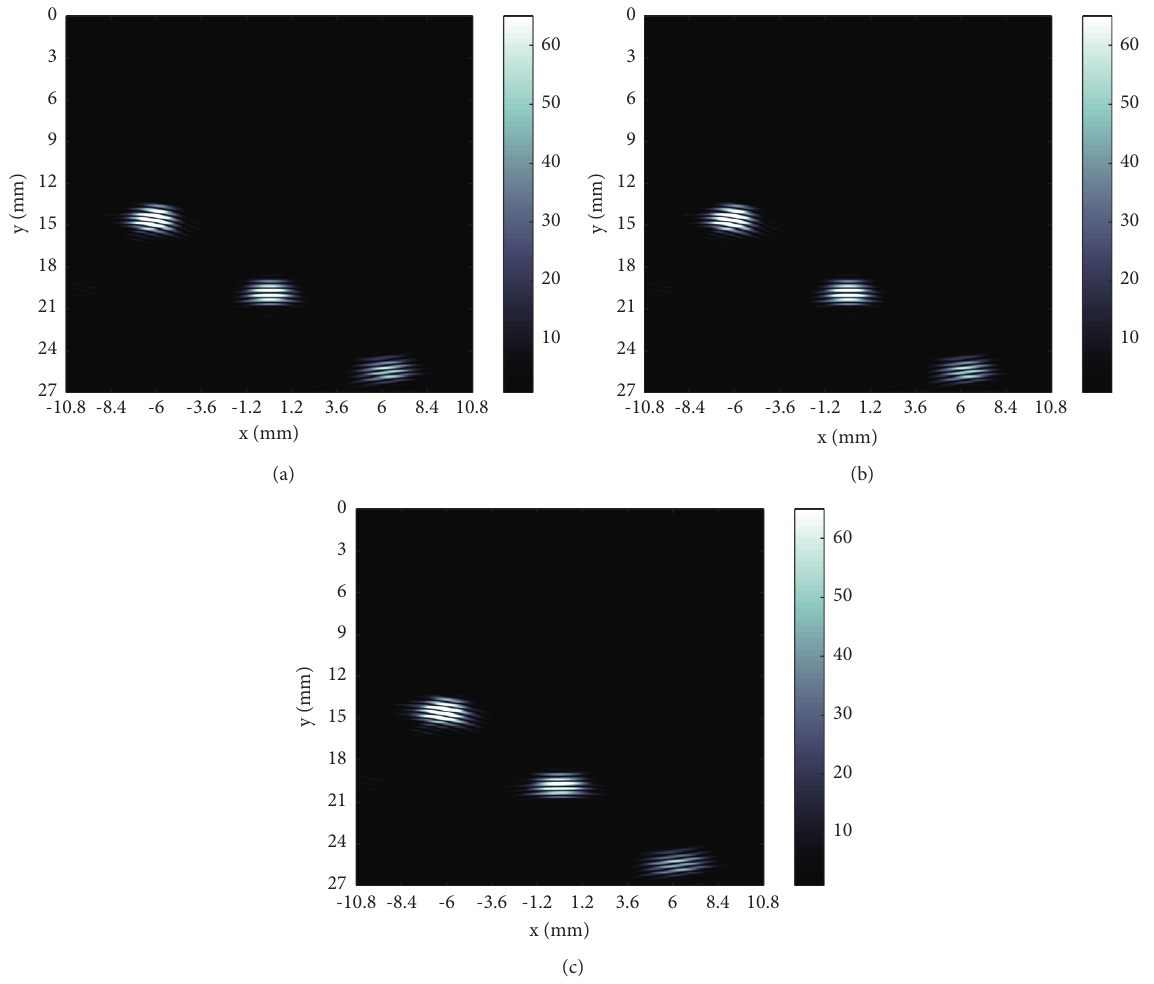
Figure 5: Focused imaging of a single medium. (a) TFM. (b) SFM-1 (in equation (4), j � 7 : 23). (c) SFM-2 (in equation (4), j � 1 : i ).